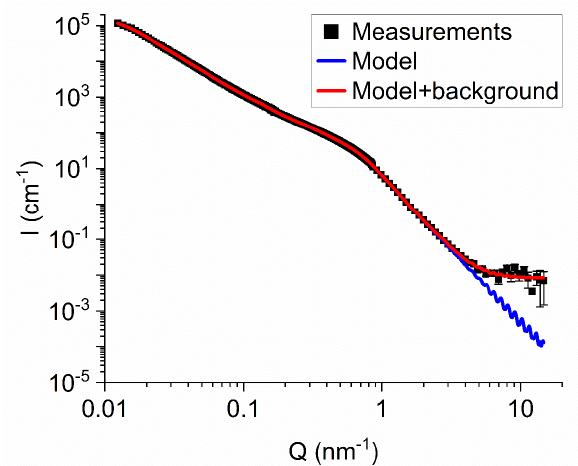
Figure 4. Comparison of measured and simulated intensity I (cm −1 ) of neutron scattered as a function of the transferred momentum Q (cm −1 ) for the F-DND sample. Black squares denote the experimental data. The thin blue line shows the results of the simulation within the model of discrete-size diamond nanospheres, and the thick red line contains in addition the background intensity of 9·10 −3 nm −1 . Figure 5 shows the mass distribution of populations of DNDs and clusters of different generations evaluated within the model of discrete-size diamond nanospheres for the F-DND sample. Although the mass fraction contained in large clusters is relatively small, they determine the neutron scattering in the region of small transferred momenta Q shown in Figures 3 and 4.